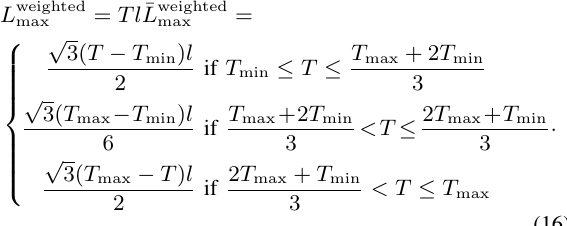
Figure 5: Weighted admissible hexagon of { L; M } in function of T (with N = 0 )